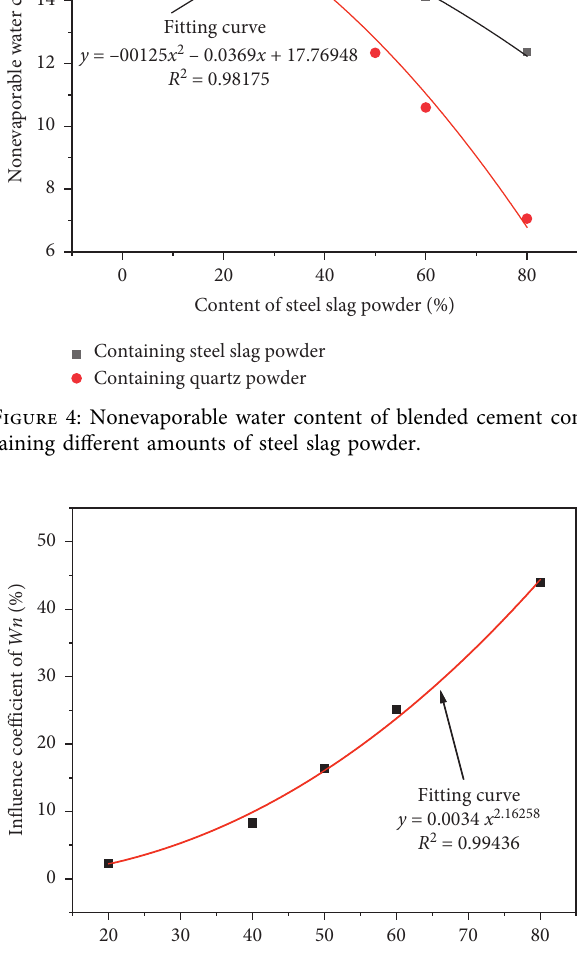
Fitting curve y = 0.0034 x 2.16258 R 2 = 0.99436